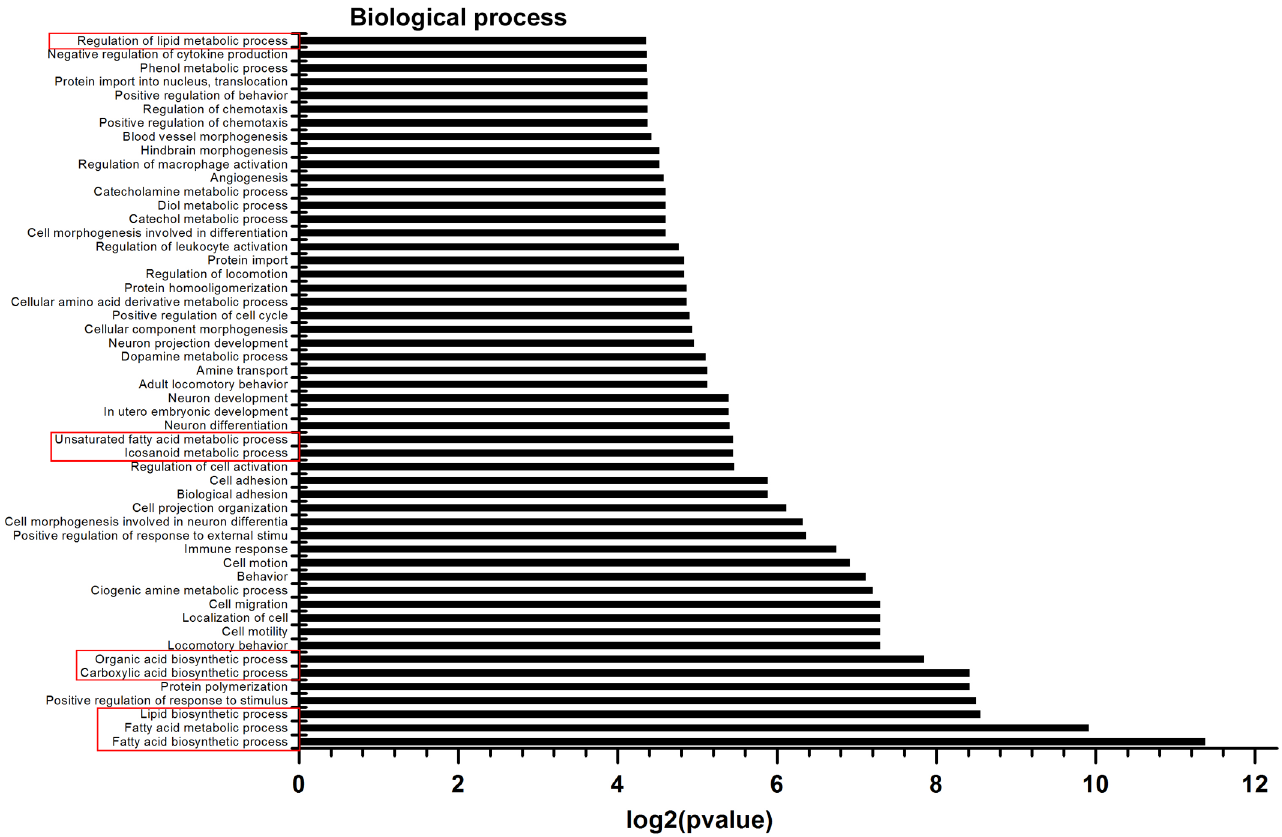
Fig 2. Microarray biological process (GO Ontology) classification. The x-axis indicates the likelihood [ − log2(pvalue)] in a category, and the y-axis means the different subcategories of biological process. The GO terms related to lipid metabolism are represented by red